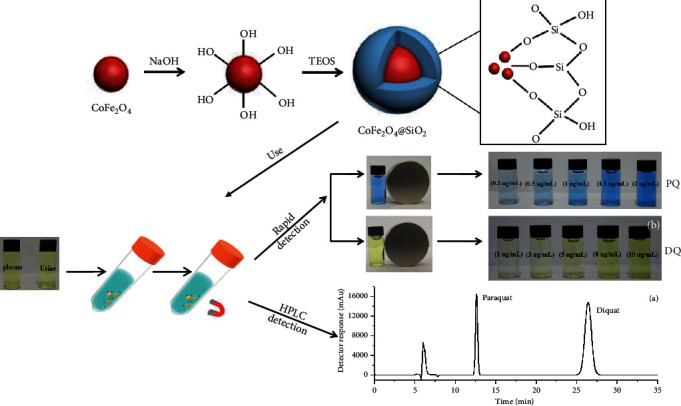
Preparation of CoFe2O4@SiO2 and the MSPE procedure for paraquat/diquat in plasma and urine.